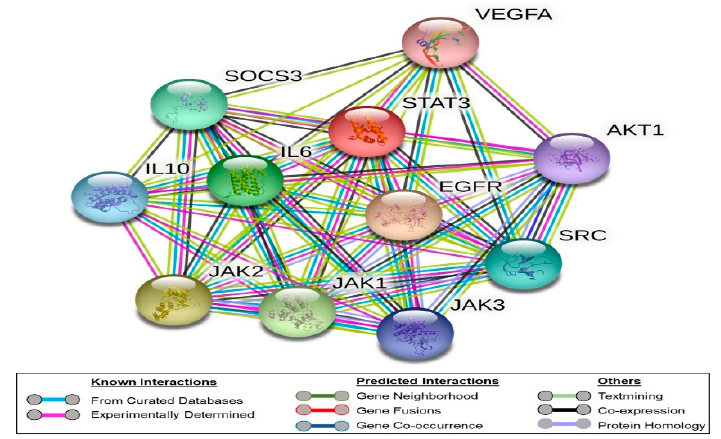
Figure 2. Network of protein–protein interaction as represented by the STRING database. The nodes refer to the proteins under study, while the edges represent the evidence channels used in the prediction. The edges are color-coded, as shown in the legends section of the figure.